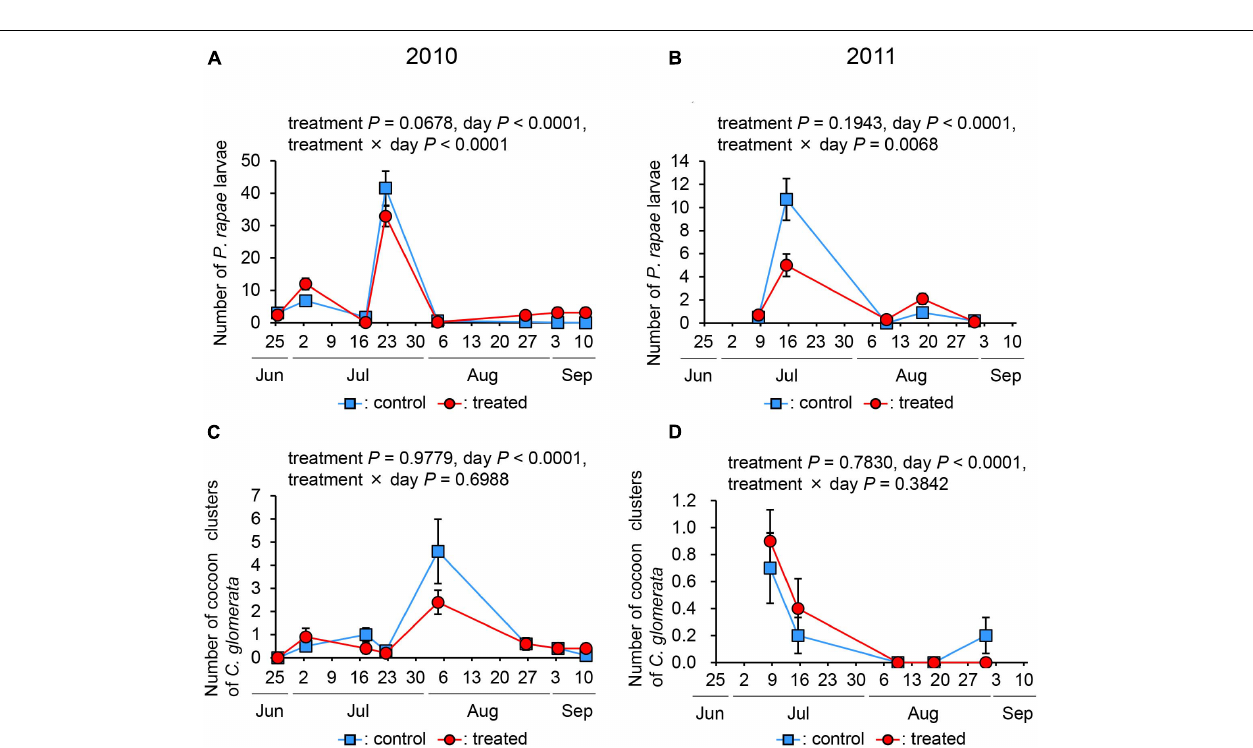
FIGURE 4 | The number of Pieris rapae larvae (A,B) and Cotesia glomerata clusters of cocoons (C,D) in treated and control plots in 2010 and 2011.